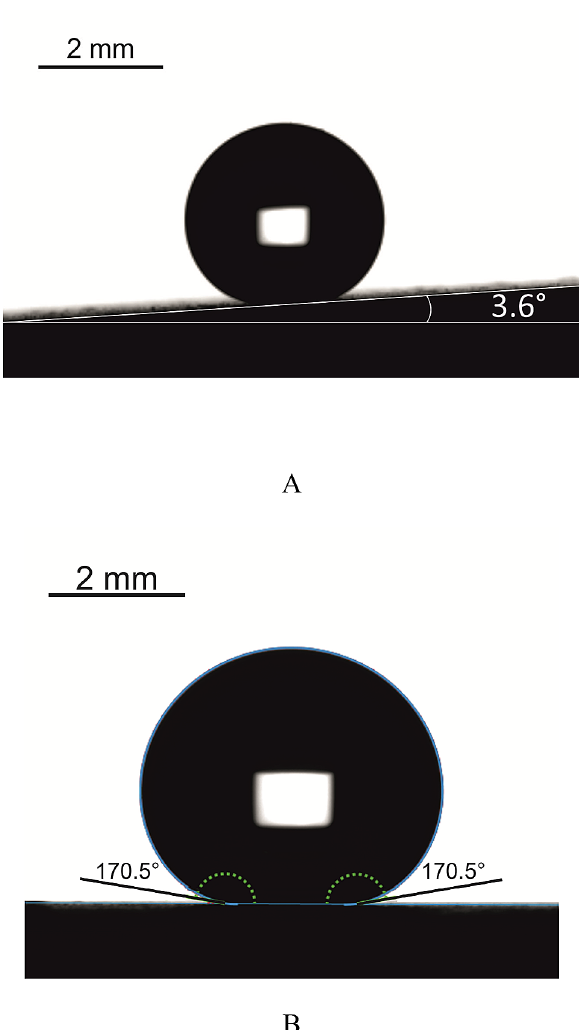
Figure 5. ( A ) Sliding angle of 3.6° established for 5 μl water droplets deposited on the omniphobic surfaces is shown. ( B ) Apparent contact angle θ = 170.5 ± 1 ◦ is